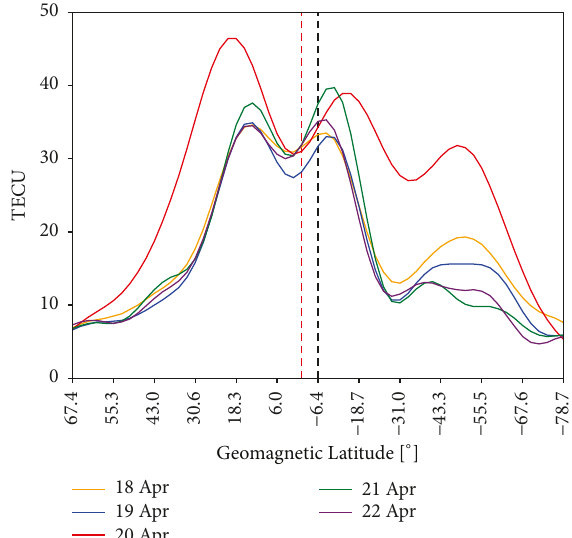
Figure 4: Shape of the VTEC for the 58.5 ∘ E meridian at 10:00 UT between April 18 and 22, 2018. A relevant range of geomagnetic latitudes is shown, 67.4 ∘ N - 78.7 ∘ S (75 ∘ N - 75 ∘ S in geographic latitudes). The vertical red and black dashed lines indicate the magnetic equator and the equator (geographic latitude = 0 ∘ ),